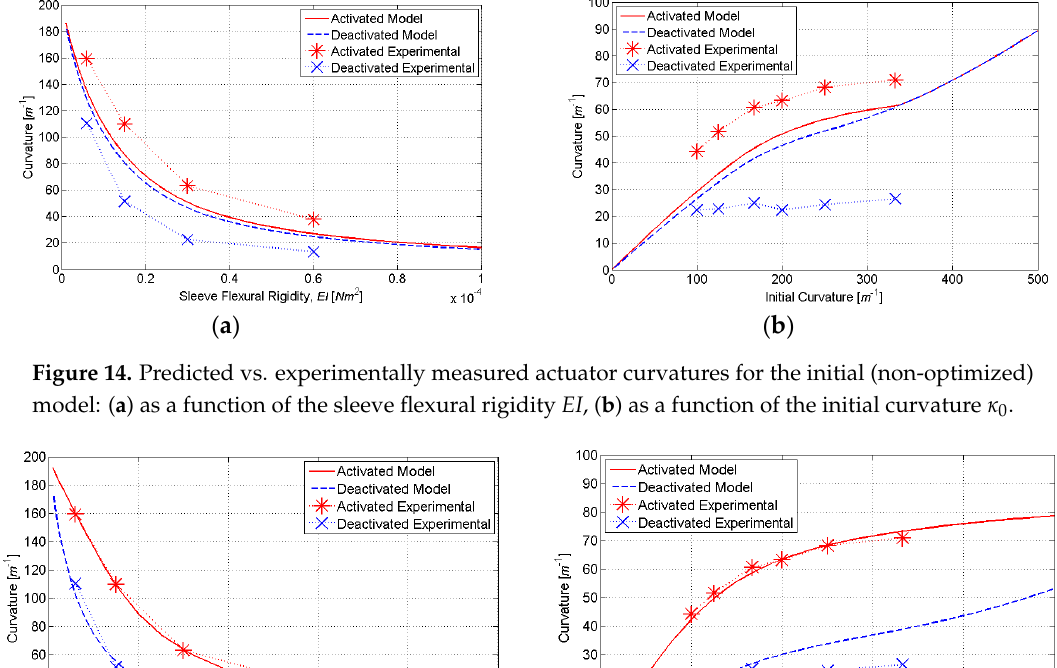
Figure 15. Predicted vs. experimentally measured actuator curvatures for the optimized model: ( a ) as a function of the sleeve flexural rigidity EI , ( b ) as a function of the initial curvature κ 0 . Table 3. Sum of squared errors (SSE) for initial (non-optimized) and optimized models. SSE Deactivated SSE Activated SSE Sum Initial Model 4792 2483 7263 Optimized Model 478.1 Percent Improvement